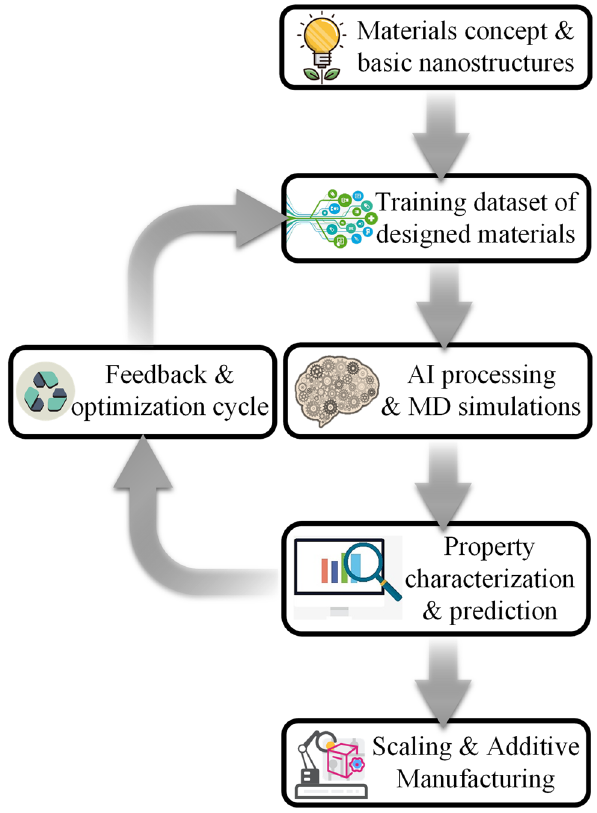
Figure 5: Flowchart of nanoengineering combined with AI for material modi fi cation and design. The process mainly involves the following steps. The fi rst step is to get the material concept for modi fi cation and design, and to obtain the information of material structures. The dataset of designed materials is then collected from experiments or ab initio simulations based on the density functional theory. The AI techniques are integrated into MD simulations to characterize material properties and predict material behaviors. The simulation testing is repeated for further optimiza - tion. Finally, the optimal design model is turned into new products with additive manufacturing for practical